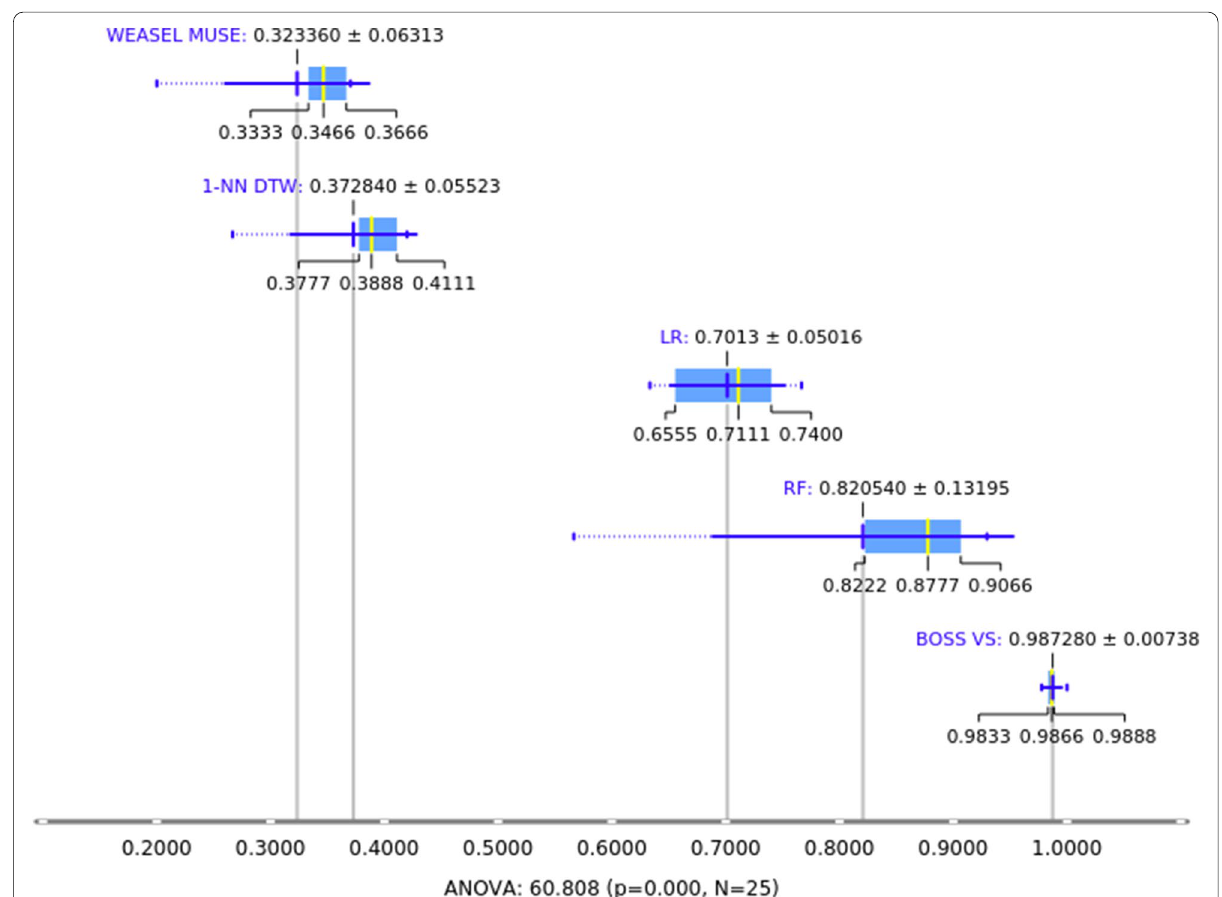
Fig. 12 The result of comparing the 95% confidence interval (CI) of the accuracy of five models using five scenarios of data size. This illustrates the scalability of each model’s performance in classification. The accuracy of the BOSS VS model fell into CI = 0.9872 ± 0.0073 resulting in the best